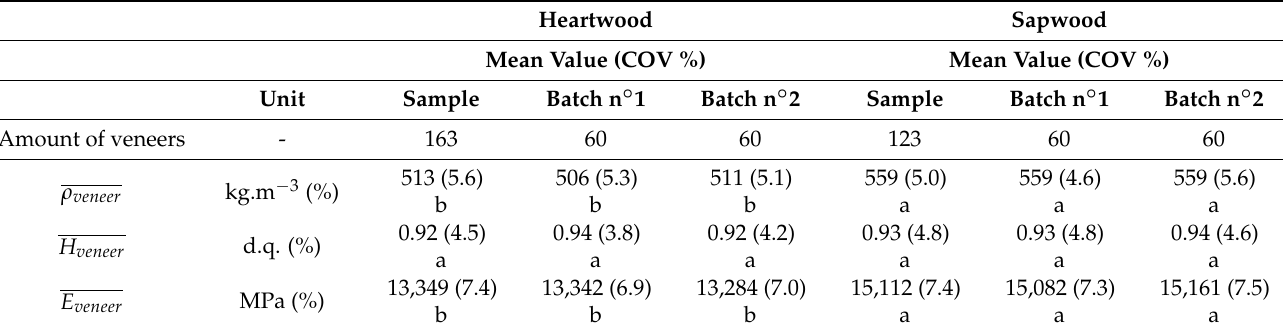
Table 3. Batches equivalence according to considered criteria (12%